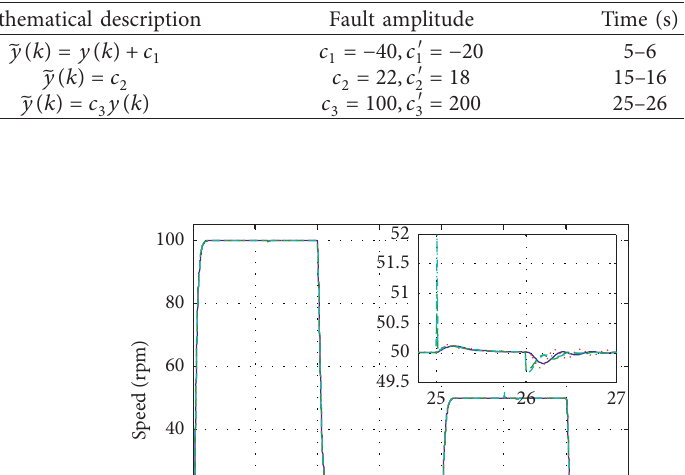
Table 4: Sensor fault information.